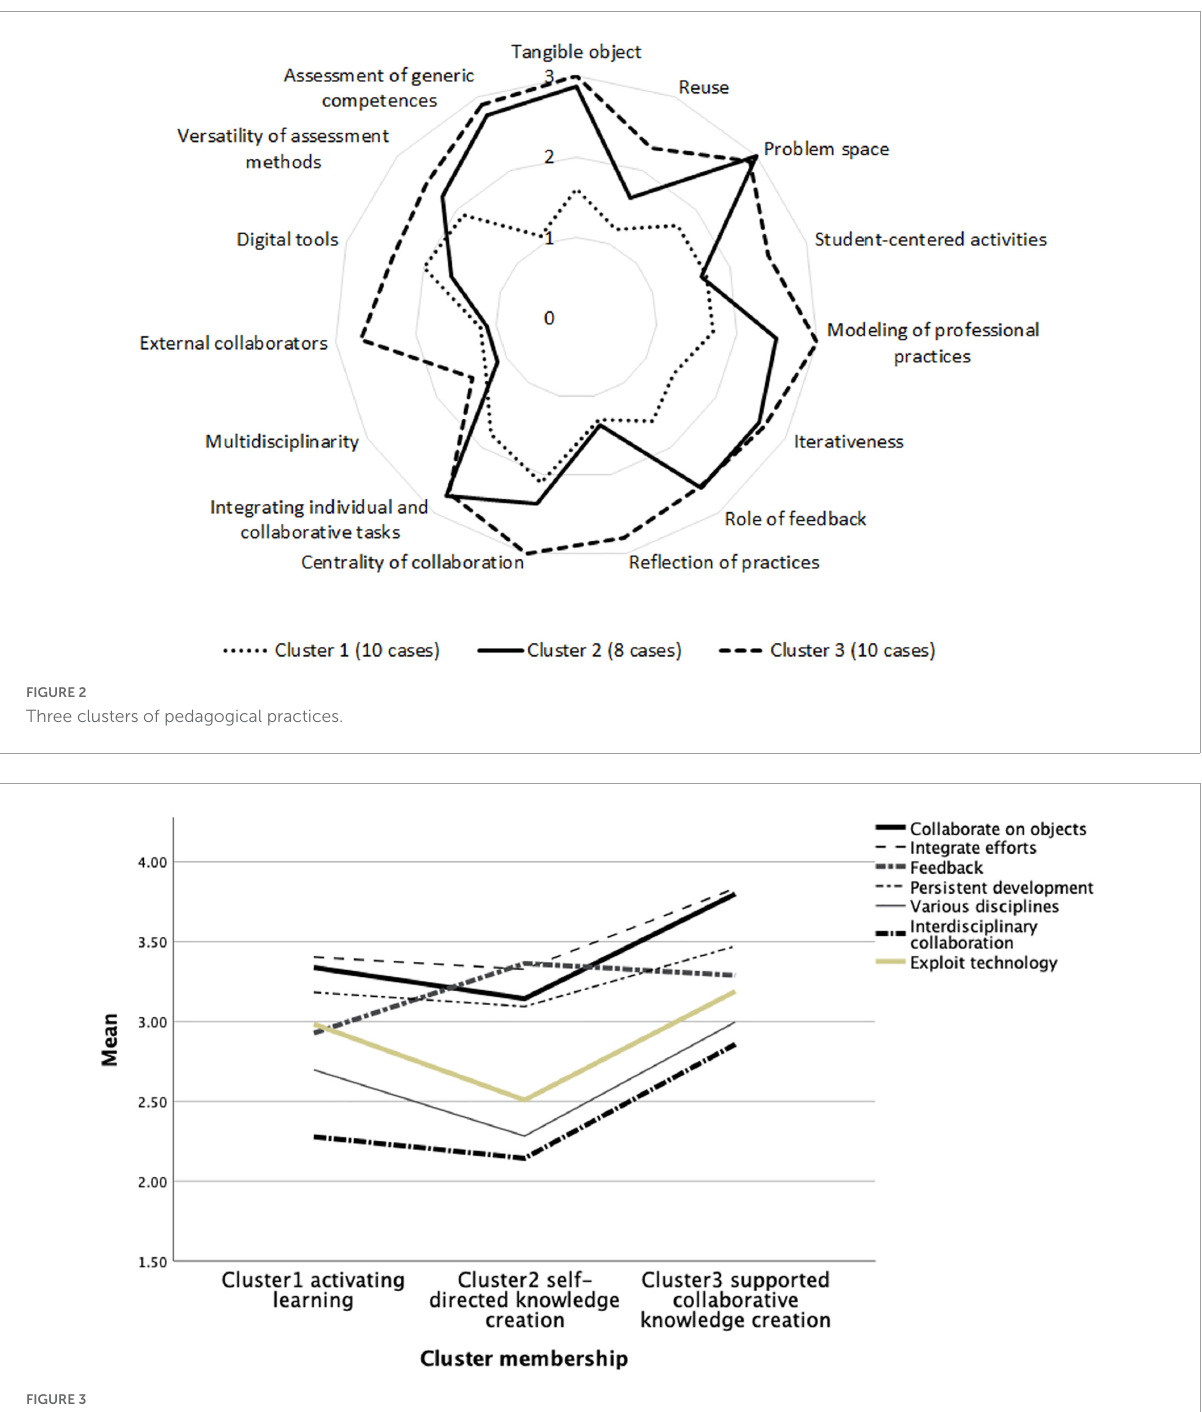
creation with systematic support for epistemic and group